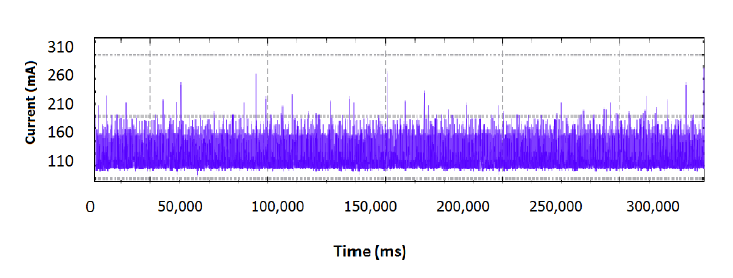
Figure 7. IP Camera Normal